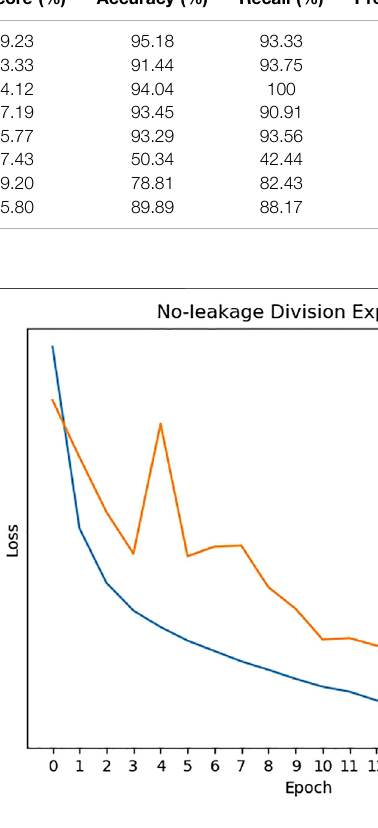
FIGURE 5 | The loss of the random division experiment. FIGURE 6 | The loss of the no-leakage division